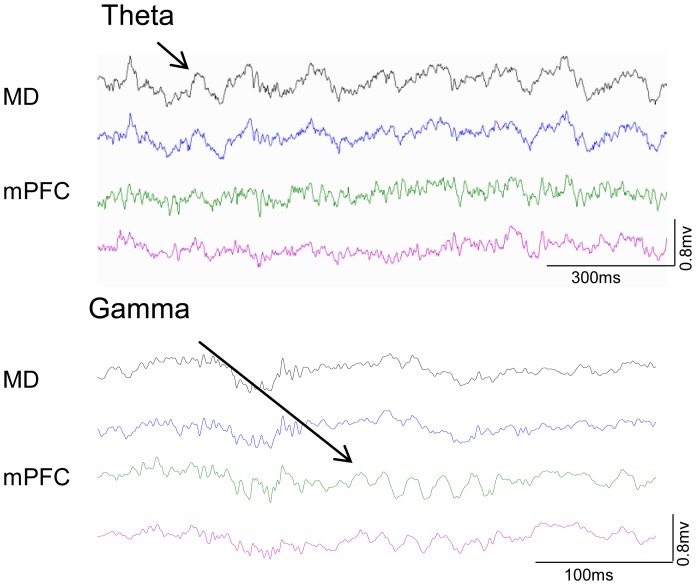
LFP recording in MD and mPFC during behavior.Representative LFP traces recorded from the four electrodes during the final session. LFPs in the MD exhibit prominent theta band (∼7–8 Hz) oscillations, whereas LFPs in the mPFC show prominent gamma band (∼50 Hz) oscillations.